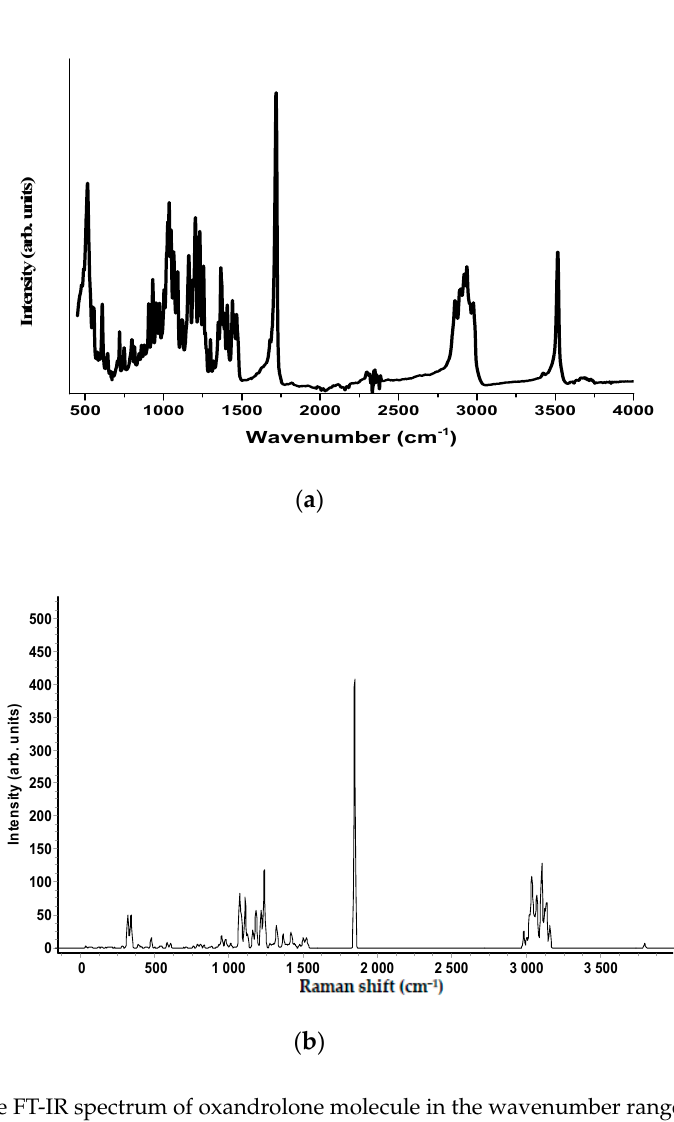
Figure 3. ( a ) The FT-IR spectrum of oxandrolone molecule in the wavenumber range 4000–400 cm − 1 ; ( b ) The simulated FT-IR spectra of oxandrolone computed with a B3LYP/6-311G (d, p) level of theory.